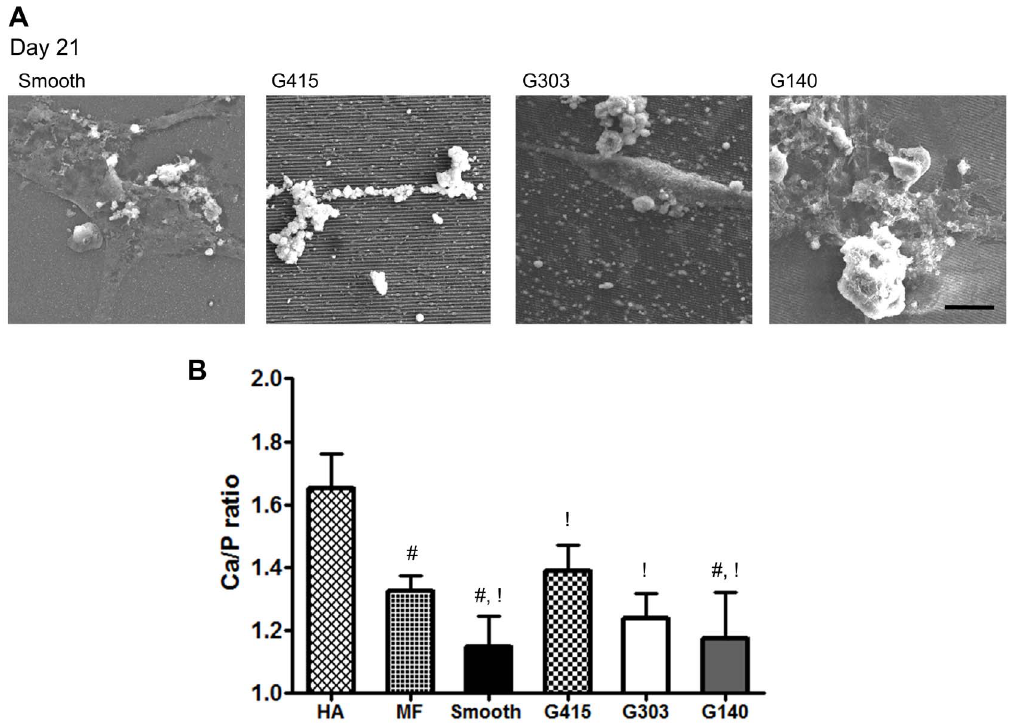
Figure 8. Ca:P ratios of mineral deposited on G415 substrates were similar to those found in mouse bone. (A) SEM micrographs revealed the presence of mineral after MSCs were cultured for 21 days in osteogenic media (OBM) on both smooth and nanotopographic PMMA films. Alignment of mineral was observed on the G415 substrate. Scale represents 10 m m. (B) Quantification of Ca:P ratios via XEDS revealed no significant differences between the G303, G140, and smooth PMMA substrates. The G415 films supported mineral with significantly higher Ca:P ratios compared to the other PMMA films, with values similar to those of native bone from mouse femur (MF). The Ca/P ratio of purified hydroxyapatite (HA) was quantified as a positive control. Symbols # and ! indicate that Ca:P ratios observed in MF and on G415 substrates were significantly higher ( p , 0.05, some comparisons showed greater significance) than other PMMA surfaces that share the same symbol, n $ 6.